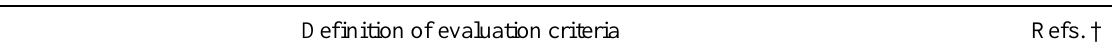
Table 4 . Criteria used to evaluate BNs as a participatory tool, based on the references